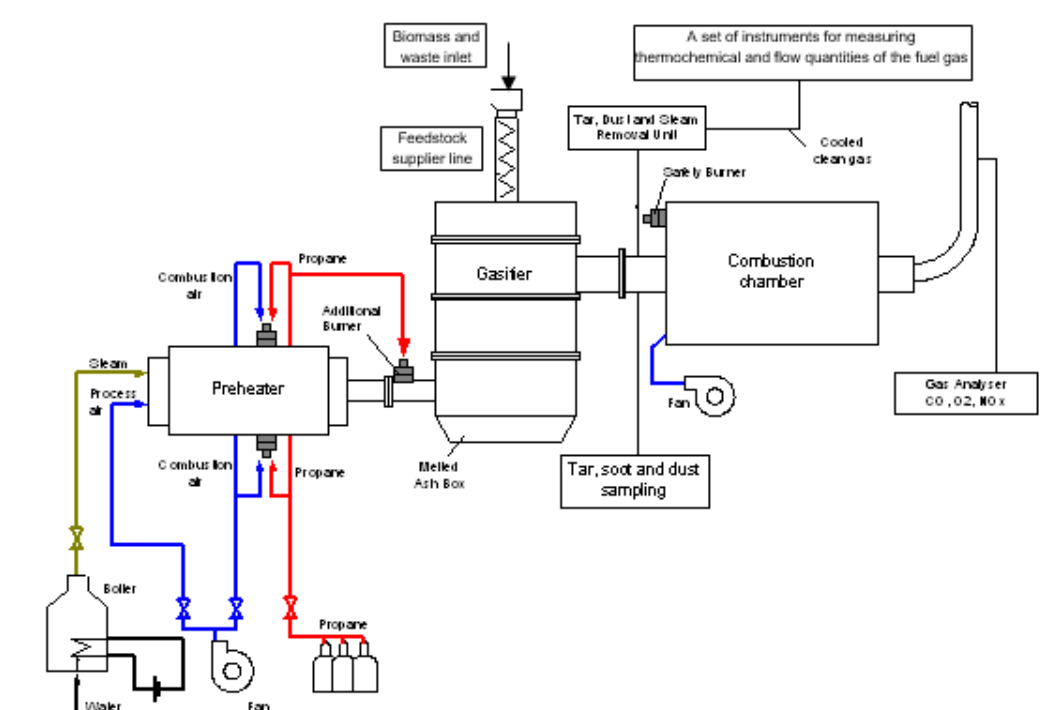
Figure 7. HiTAG / HiTSG test facility with a continuous gasifier. Figure 7. HiTAG/HiTSG test facility with a continuous gasifier. Figure 7. HiTAG/HiTSG test facility with a continuous gasifier.